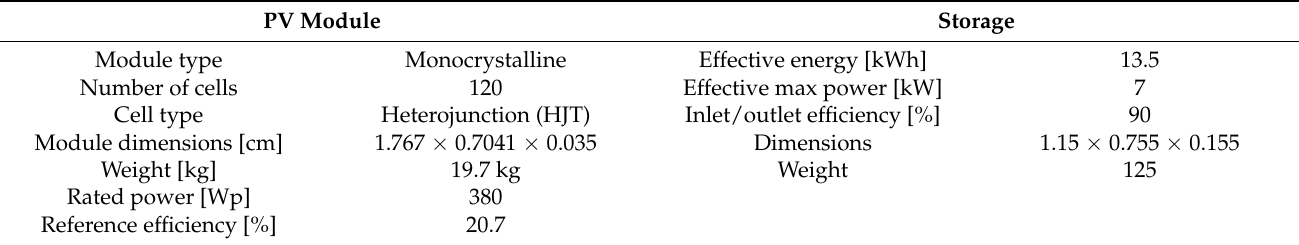
Table 9. Technical characteristics of the PV module and the storage system.